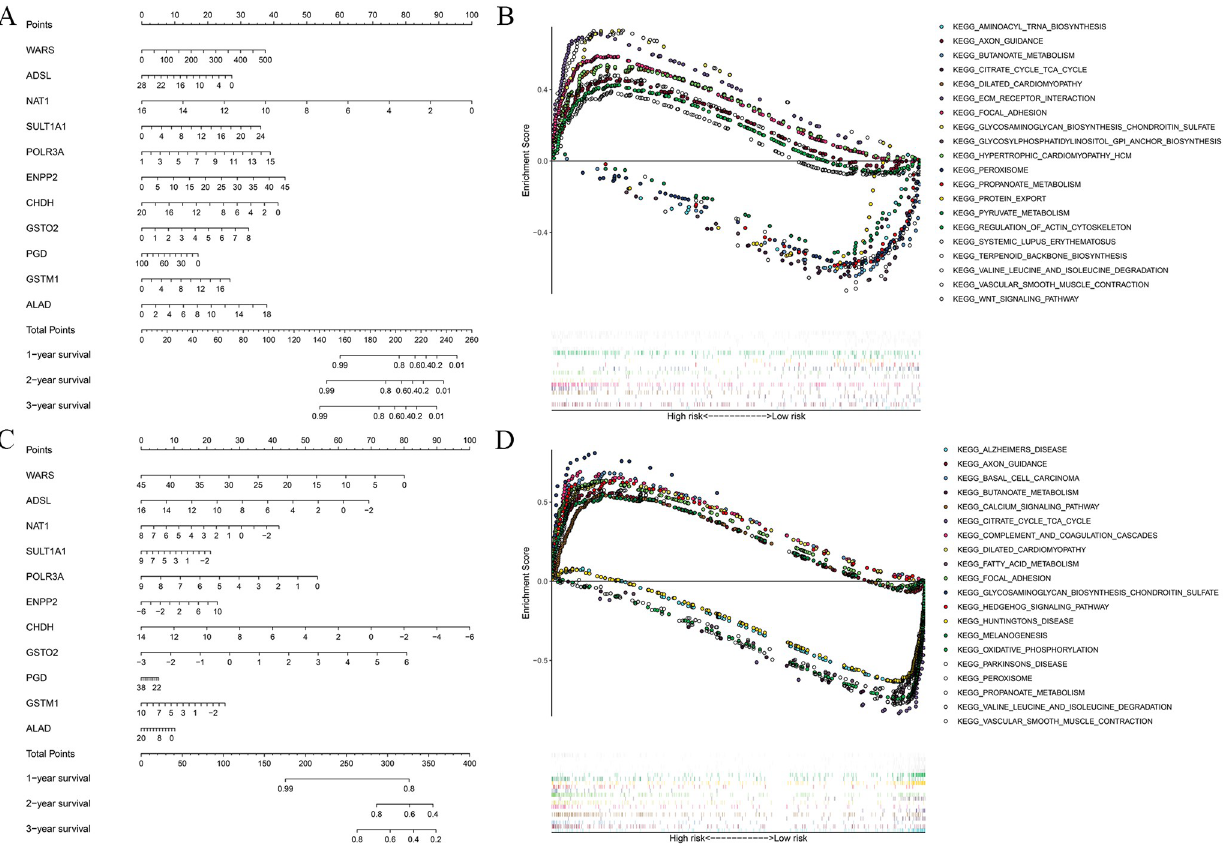
Fig 4. Nomogram and GSEA analysis. The nomograms of the TCGA-CRC(A) and GSE39582(C) cohorts show that each gene in the prognostic model has a different contribution to the prediction of prognosis. In addition, compared with the long-term survival period (2 or 3 years), the prognostic model has better predictive value for the short-term survival period (1 year). GESA analysis of the TCGA-CRC(B) and GSE39582(D) cohorts showed that the genes of the prognostic model were significantly enriched in metabolism and tumor-related signaling pathways.